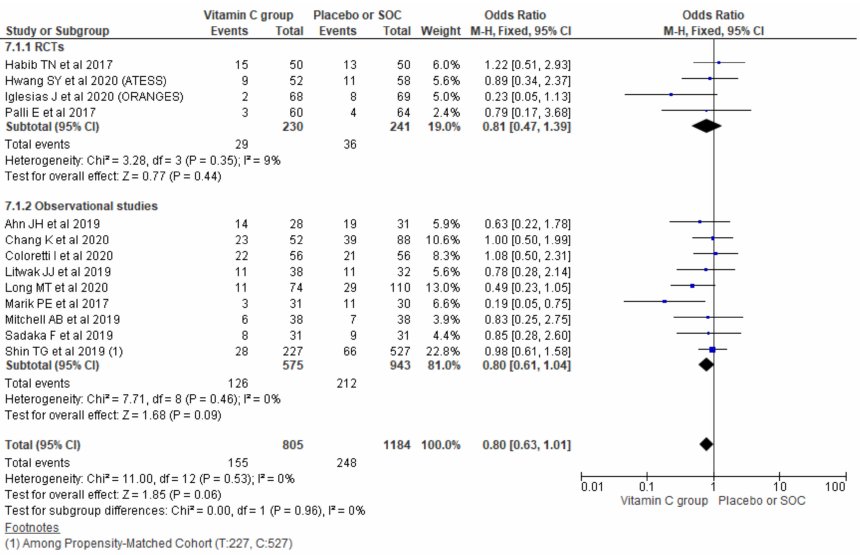
Figure 8. Forest plot showing requirement of RRT for AKI using a random-effect